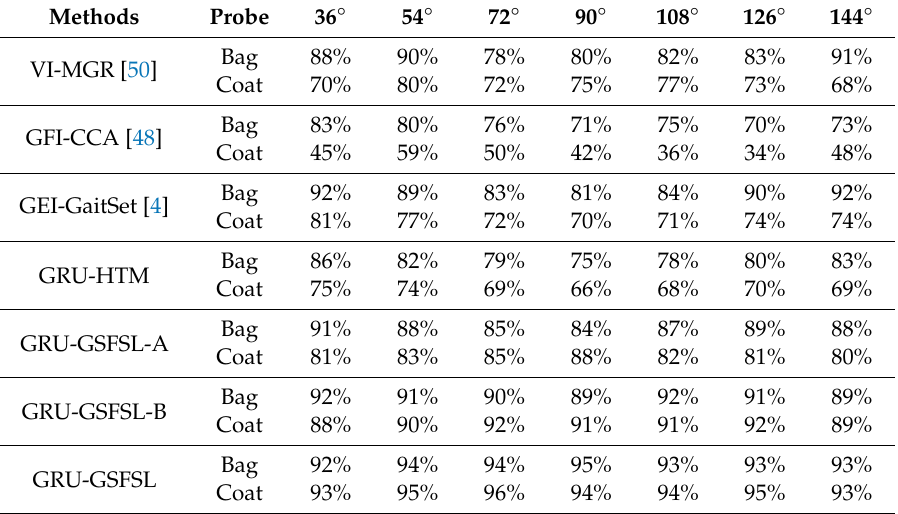
Table 3. Rank-1 recognition results of di ff erent methods under various